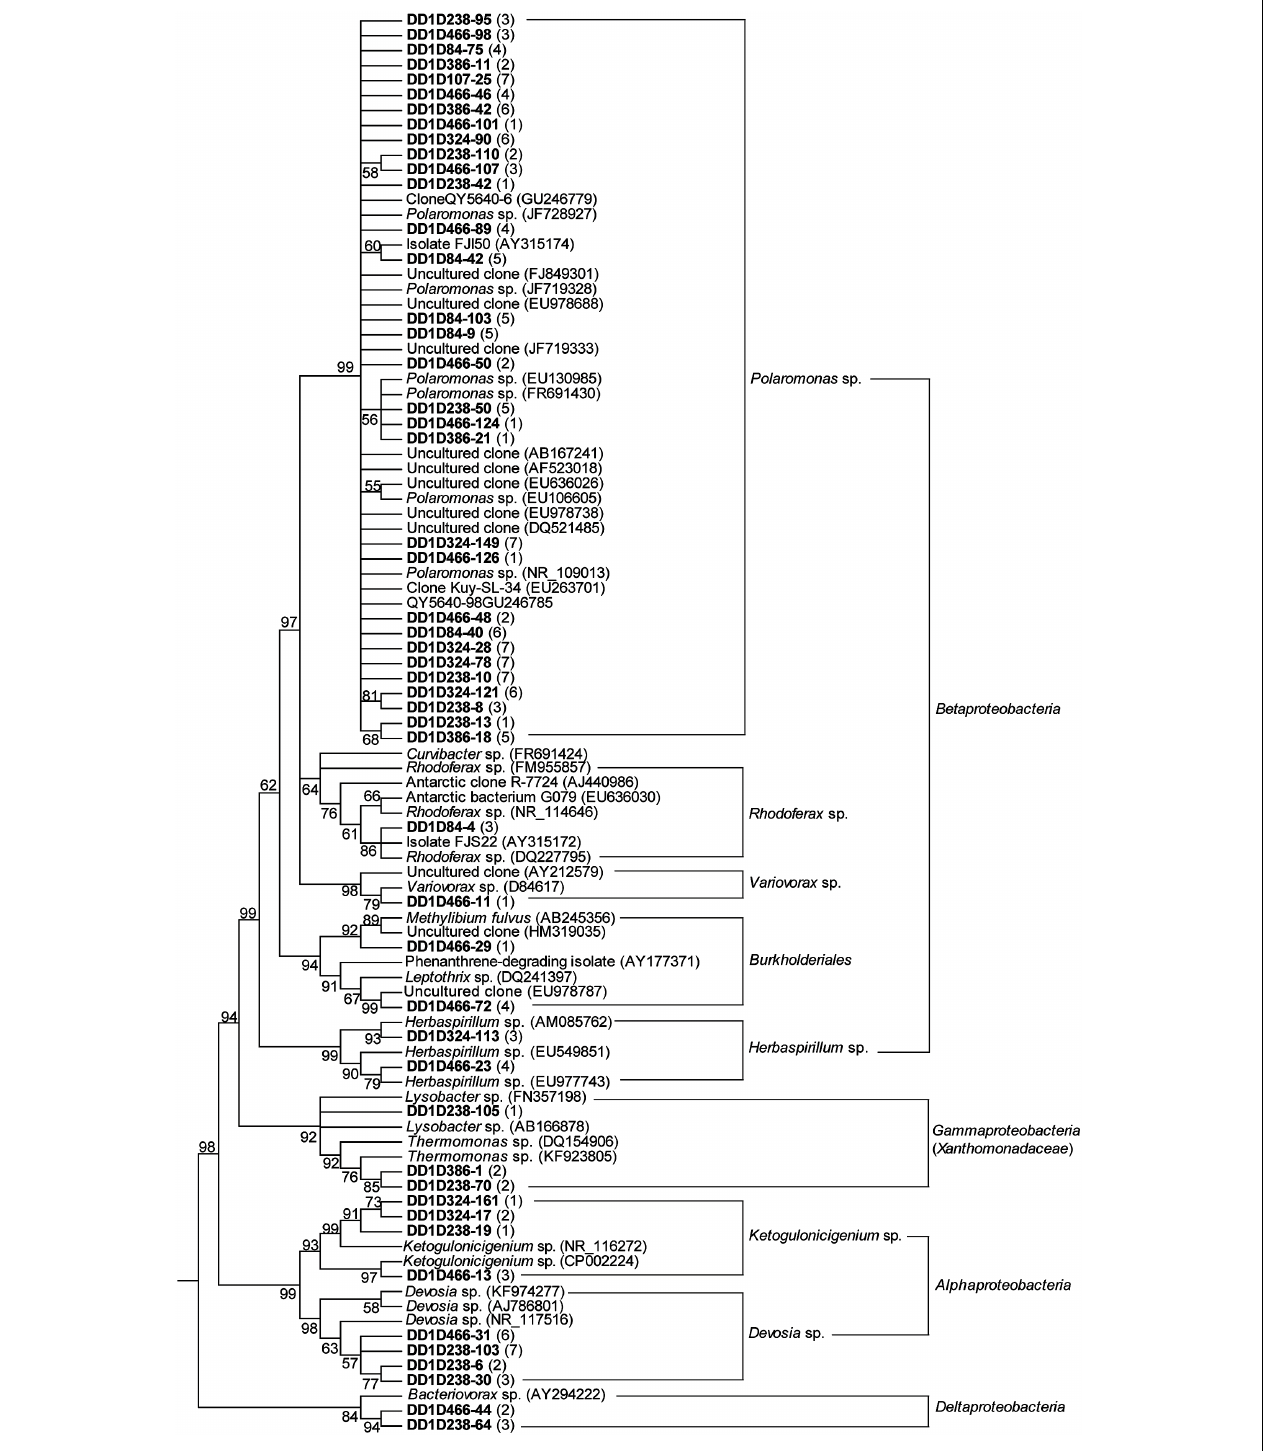
FIGURE 5 | Phylogenetic analysis of the 16S rRNA genes for Alphaproteobacteria , Betaproteobacteria, Gammaproteobacteria , and Deltaproteobacteria clones from the Dunde ice core and the closest relatives. The tree was generated by the Neighbor-Joining method after sequence alignment, and rooted with two Methanosaeta strains (accession no. AY817738 and NR102903). Bootstrap values (100 replications) were specified for each Node. Cut-off value for the condensed tree was 55%. Numbers of the obtained snow-ice clones (had the same ARDRA pattern to the sequenced representatives listed on the tree) and relative sequence affiliations corresponding to GenBank accession number were provided in parentheses. The sequences discussed in this study were noted bold. See a detailed description for the assigned sequence references and numbers in “Study Area, Data Collection, and Methodology.”